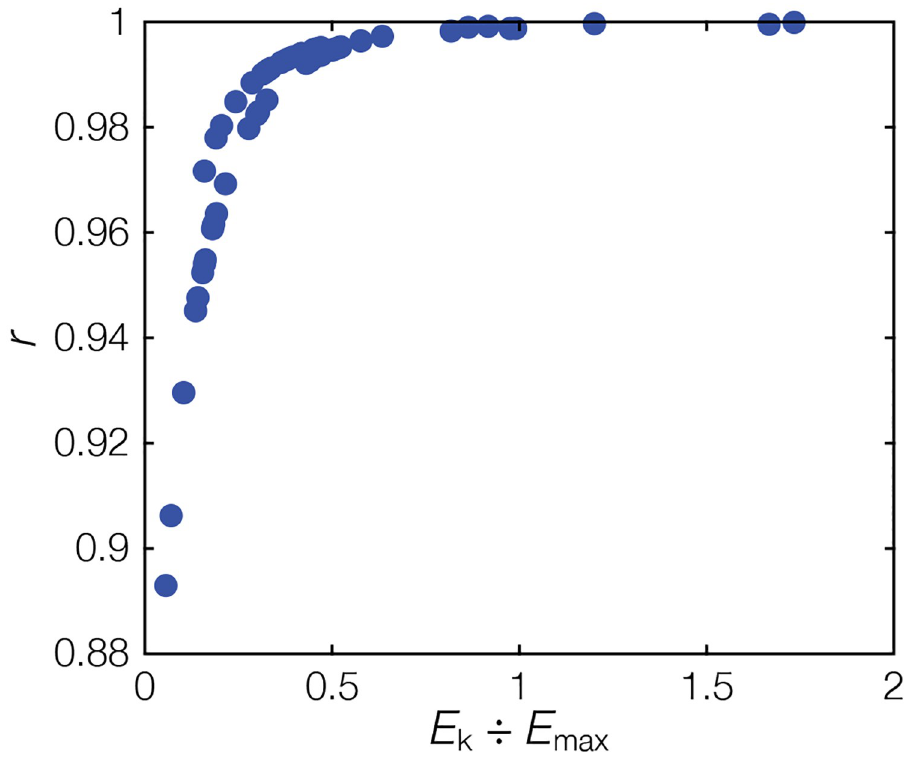
Fig 3. Relationship of light saturation / maximum irradiance ratio (E k /E max ) of the 52 published instantaneous P-E curves and the correlation coefficient ( r ) of the corresponding time-integrated P-E curves.